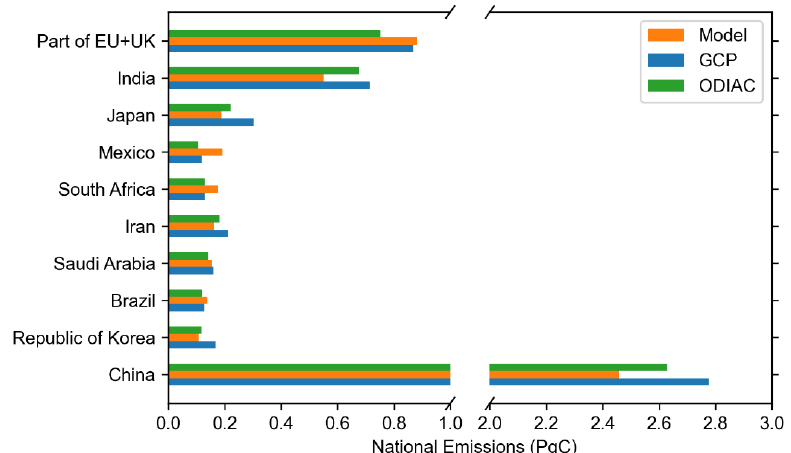
Figure 12. National and regional emissions in 2019. Included are the top 10 countries or regions out of 140 countries estimated by the model. The European Union countries did not include Cyprus, Luxembourg, Malta, Finland, and Sweden.